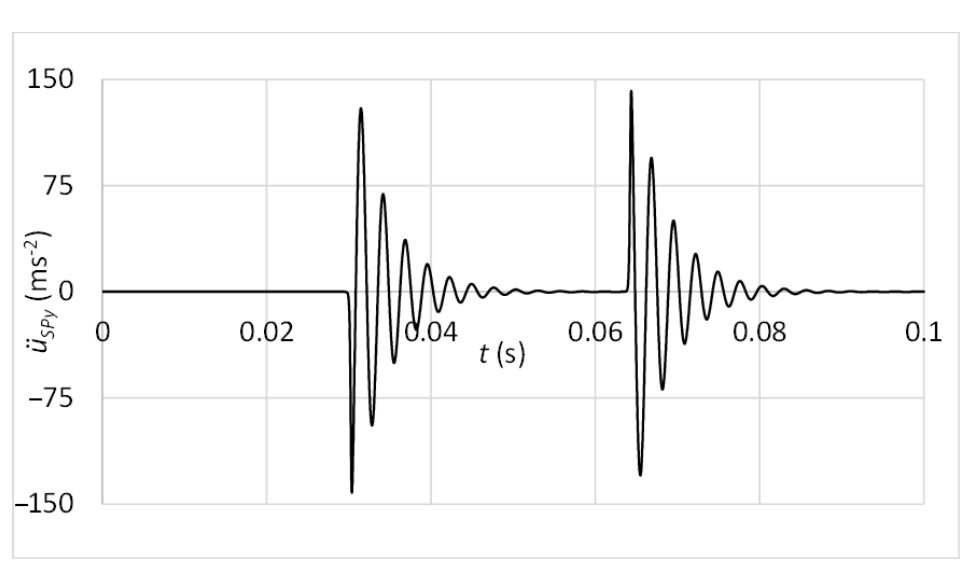
Figure 14. Vibrations at the sensor position—connection with the rubber spring and additional